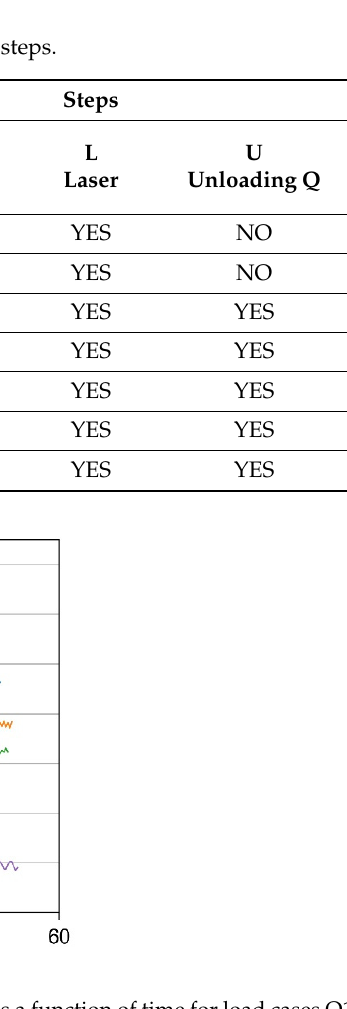
Figure 10. Deflection of the free end of the beam as a function of time for load cases Q1–Q5, meas- ured in experiments (Q1e–Q5e) and calculated in numerical simulations (Q1s–Q5s). Table 3. Parameters of the Johnson–Cook (JC) model for Inconel 718 alloy.